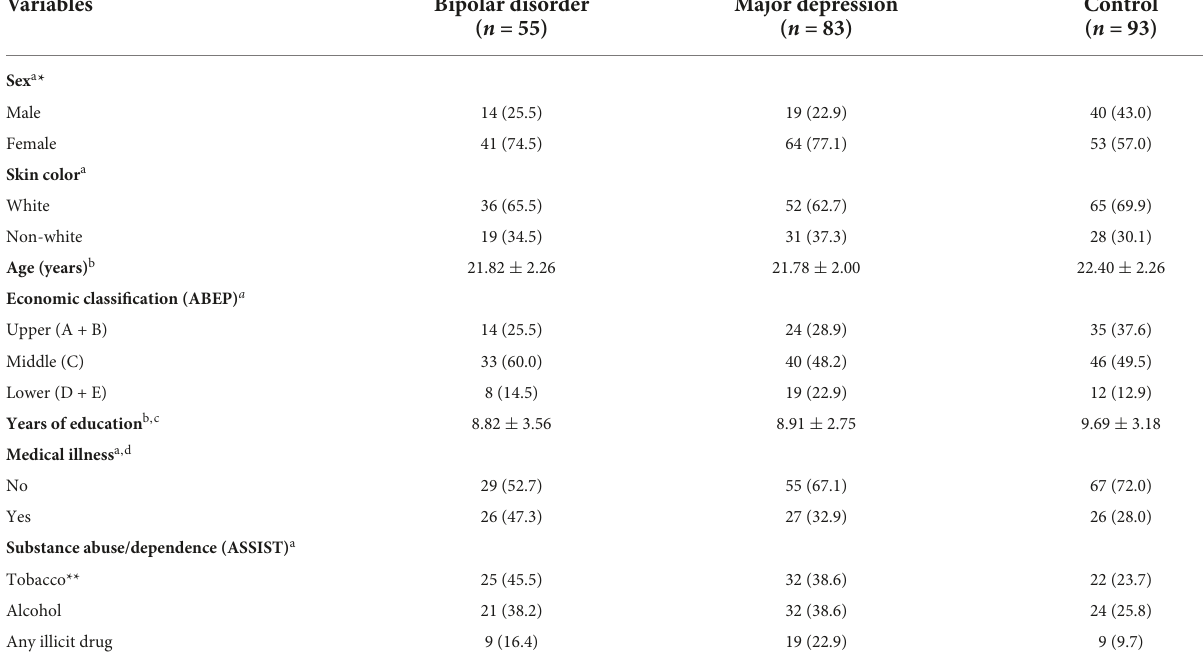
TABLE 1 Sample characteristics according to baseline diagnosis.